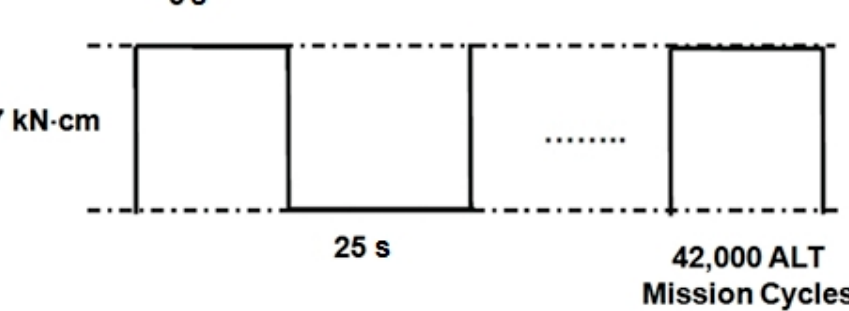
Figure 8. Duty cycles of disturbance load T L on the band clamper.